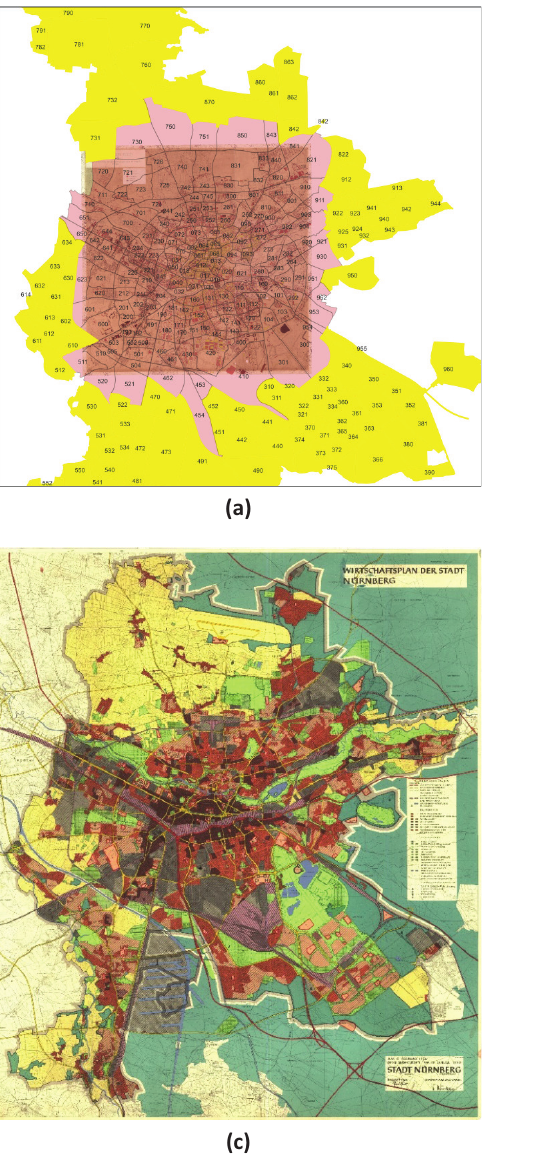
Figure 5. The three historical land cover/use maps, alongside the area covered by the bomb damage map and Districts. (a) Districts within (202 in pink) and beyond (114 in yellow) the bomb damage map of Figure 1. (b) 1940 map. (c) 1956 map. (d) 1969 map. Sources: (a) produced by the author; (b) “Grossbebauungsplan von Nürnberg und Umgegend” (1940); (c) “Wirtschaftsplan der Stadt Nürnberg” (1956); (d) “Flächennutzungsplan der Stadt Nürnberg” (1969). Table 1. Land cover/use categories for the three historical